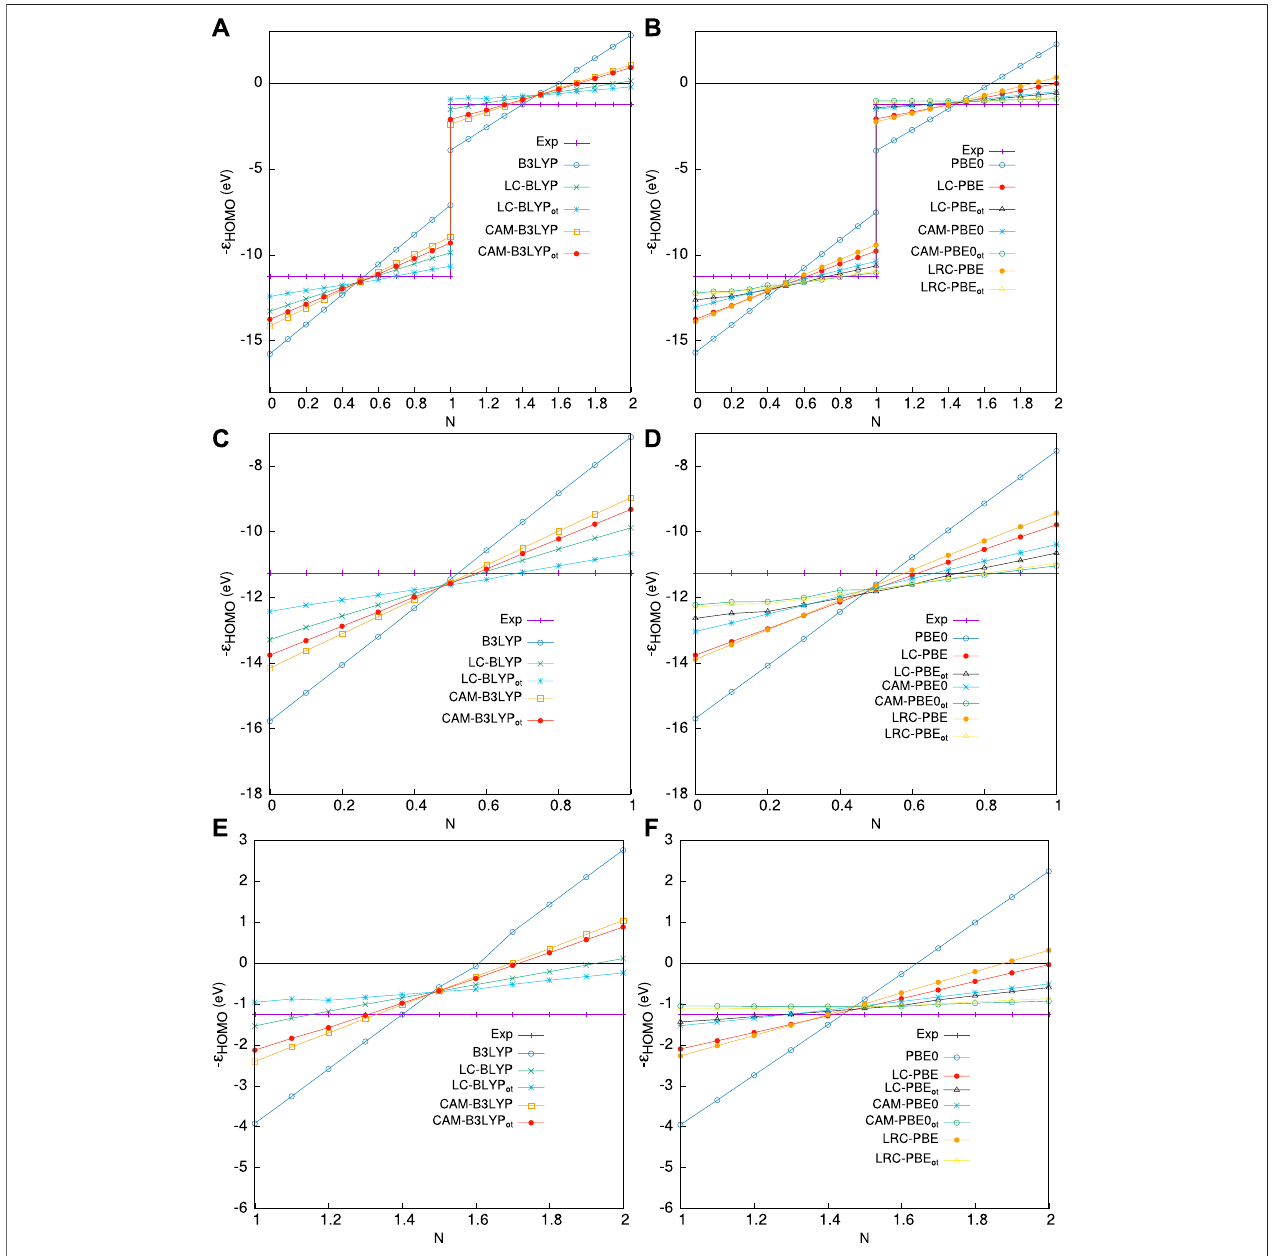
FIGURE2| PerformanceofvariousfunctionalsonfractionaloccupationinCatom.TheleftpanelshowsHOMOenergyasafractionofoccupied p -electronnumber for (A) 0, ≤ N ≤ 2, (C) 0, ≤ N ≤ 1, (E) 1 ≤ N ≤ 2, for B3LYP block functionals. Right panels (B,D,F) refer to the PBE0 block, taken from Ghosal and Roy (2022a).